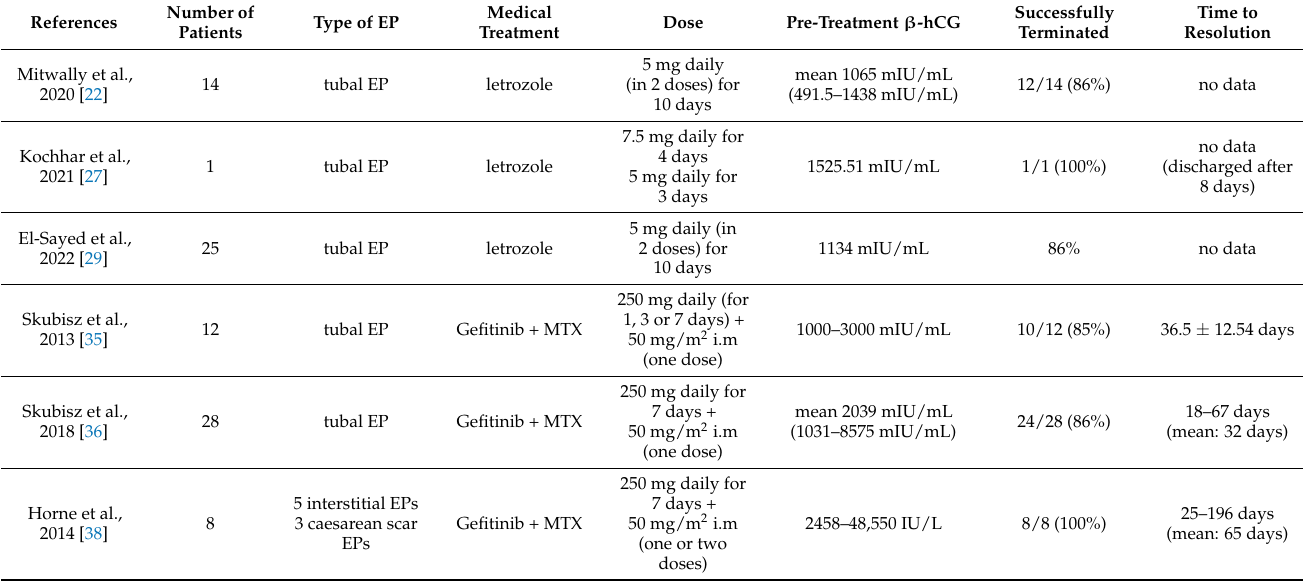
Table 1. Review of the literature describing letrozole and gefitinib treatment in